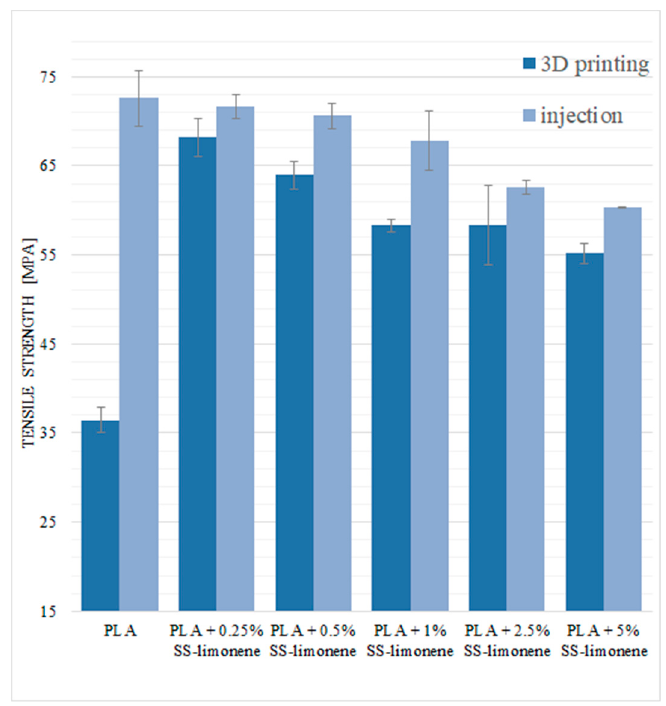
Figure 8. Tensile strength of SS-Limonene/PLA in 3D printing and injection moulding.